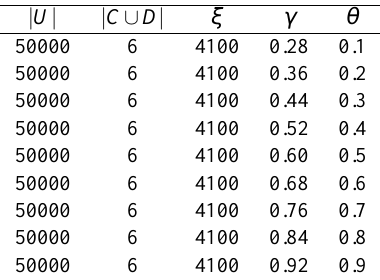
Table 7. Characteristics of artificial data sets with different re- dundancy